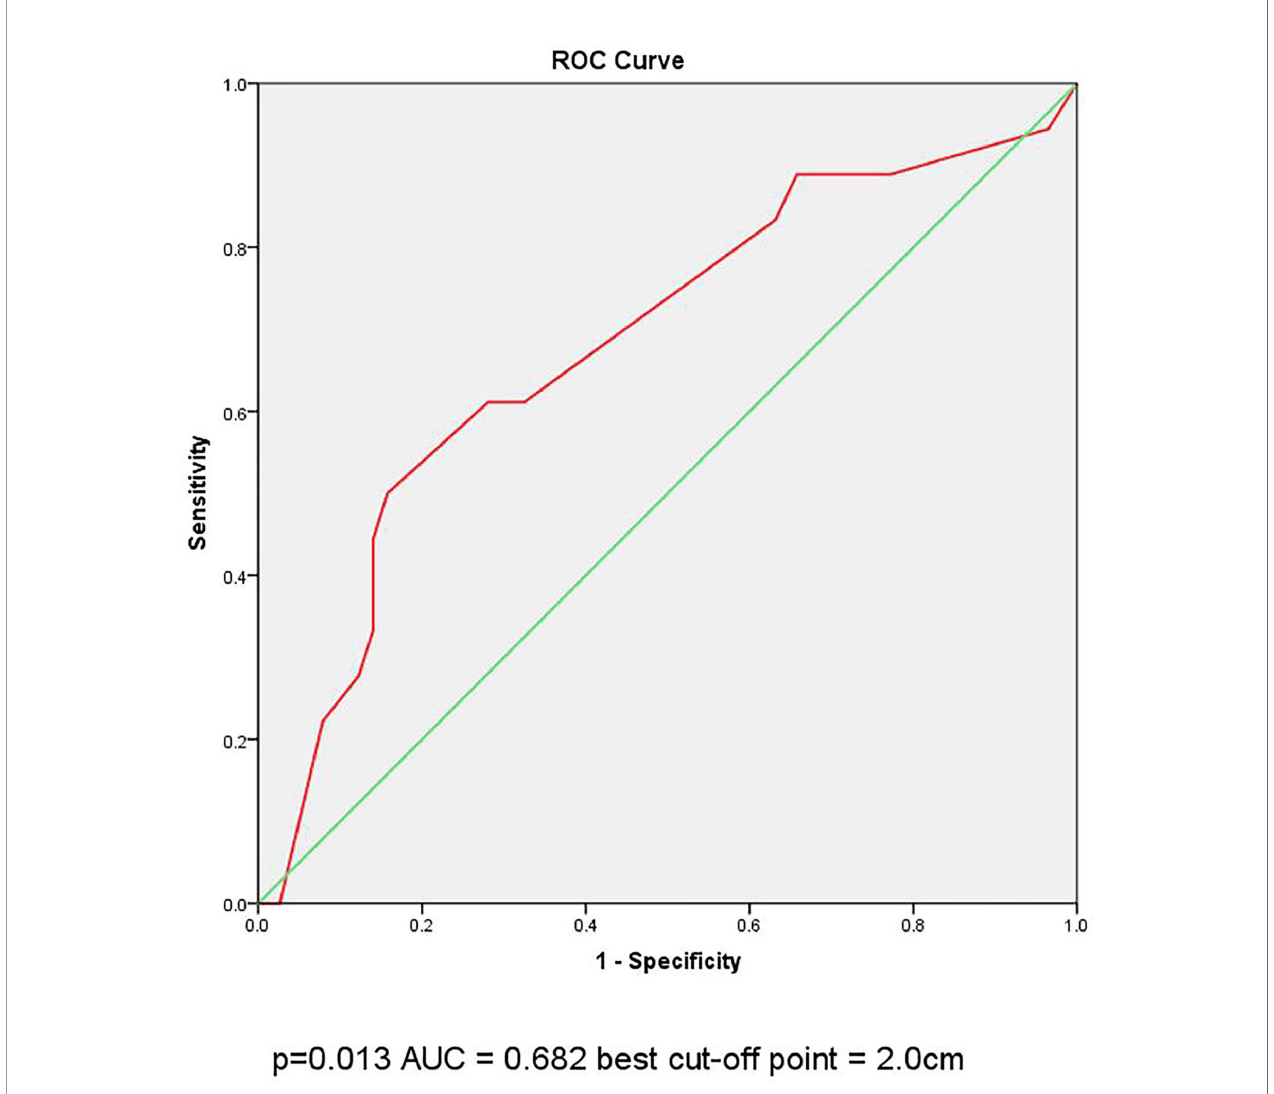
FIGURE 1 | ROC curve analysis of the cutoff point for diameter of the CPTC